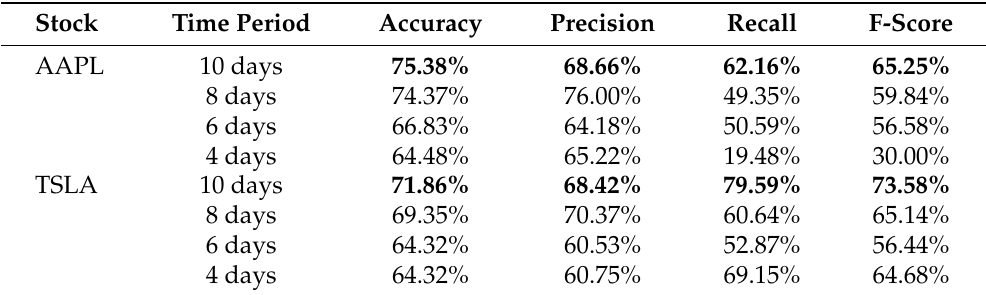
Table 6. Performance of proposed method for five hot stocks (AAPL, TSLA, IBM, AMZN, and GOOG) on different time periods (4, 6, 8, and 10